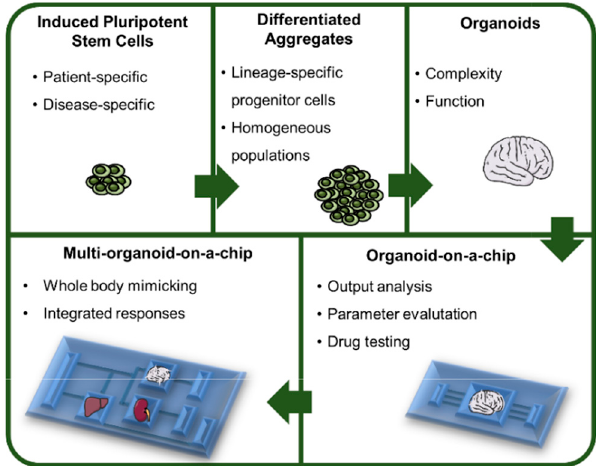
Figure 1. From human pluripotent stem cells (hPSCs) to multi-organoid platforms. The use of hiPSCs brings the possibility to generate patient- and disease-specific organoids that will contribute to advances in the fields of personalized medicine and disease modeling. These cells can be first differentiated into lineage specific progenitor cells that in turn will be able to generate organoids representing the complex interactions that exist between cells in vivo. The integration of these organoids within a culture/analysis chip provides the necessary tools to analyze different parameters that may be altered in specific conditions, such as exposure to a drug. Moreover, a chip that contains